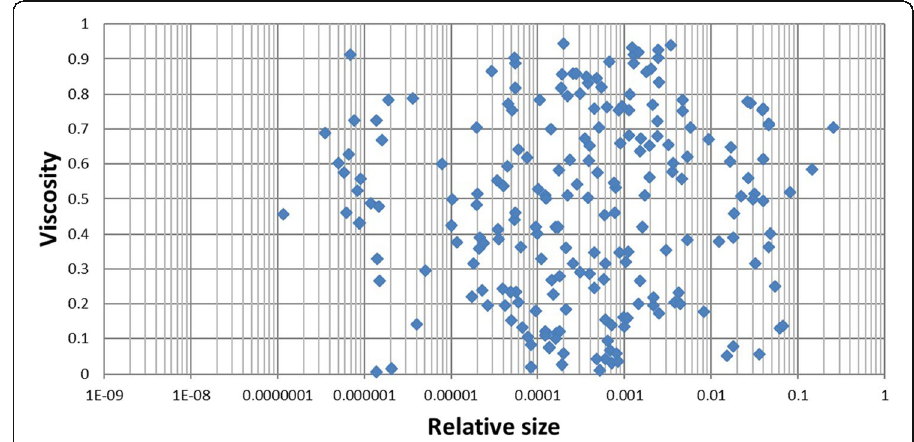
Fig. 5 Viscosity versus relative size for 2010 –